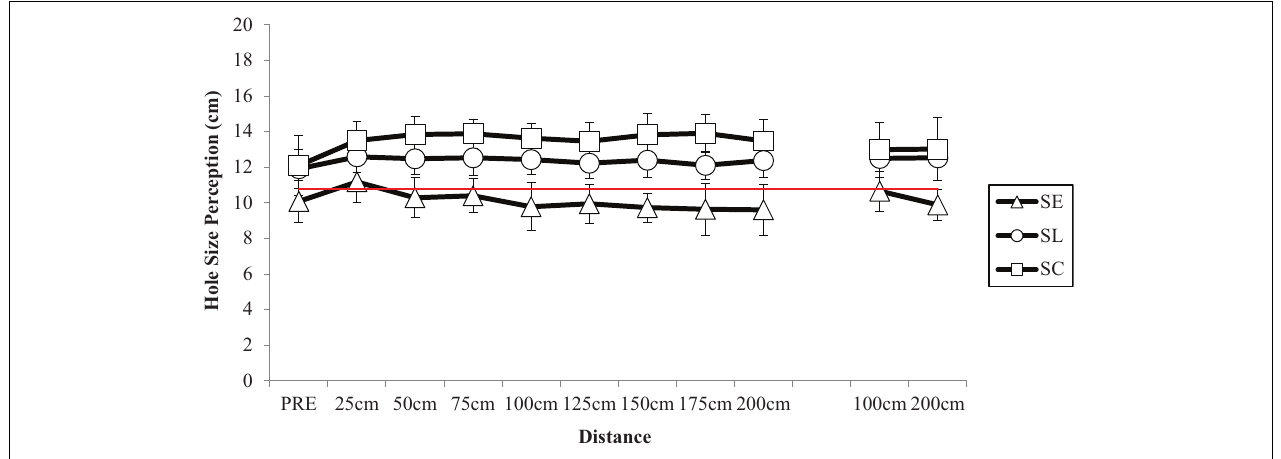
FIGURE 2 | Participants’ mean self-reported hole size perceptions by experimental group at each putting distance during the acquisition phase (Day 1) and the retention phase (Day 2). Note: the red horizontal line indicates the size of the actual putting hole (10.8 cm). SE = success early; SL = success late; and SC = self-controlled